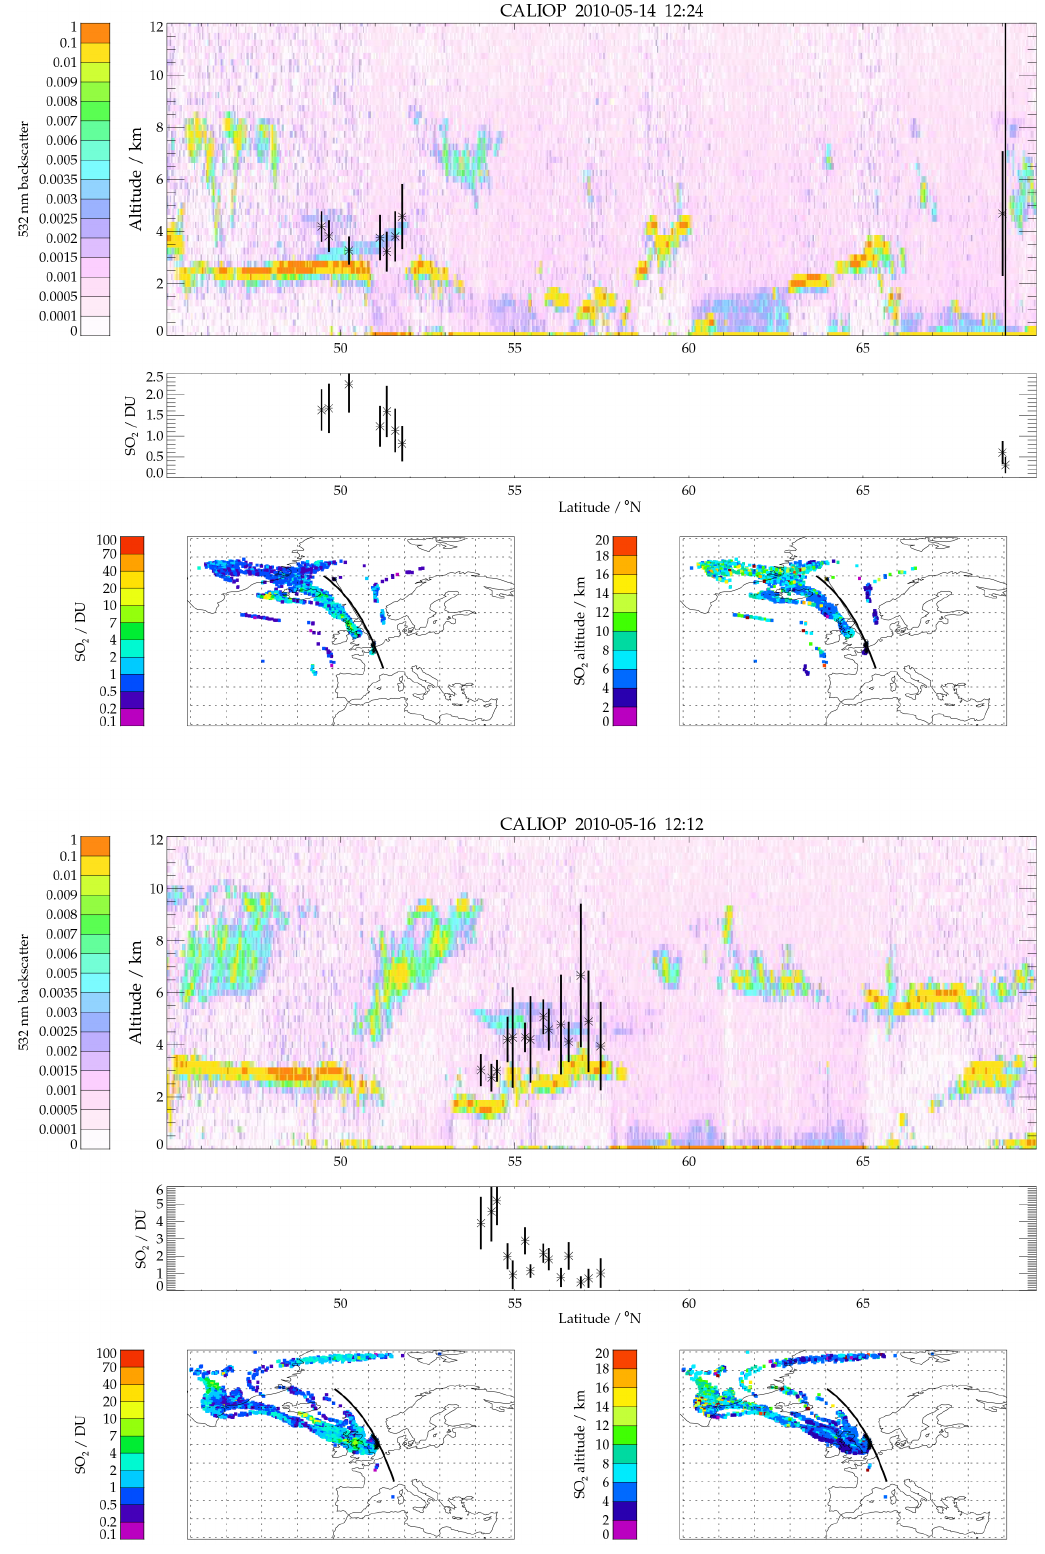
Figure 3. CALIOP-IASI coincidences for the 14 and 16 May 2010, Eyjafjallajökull plume. As Fig. 1.